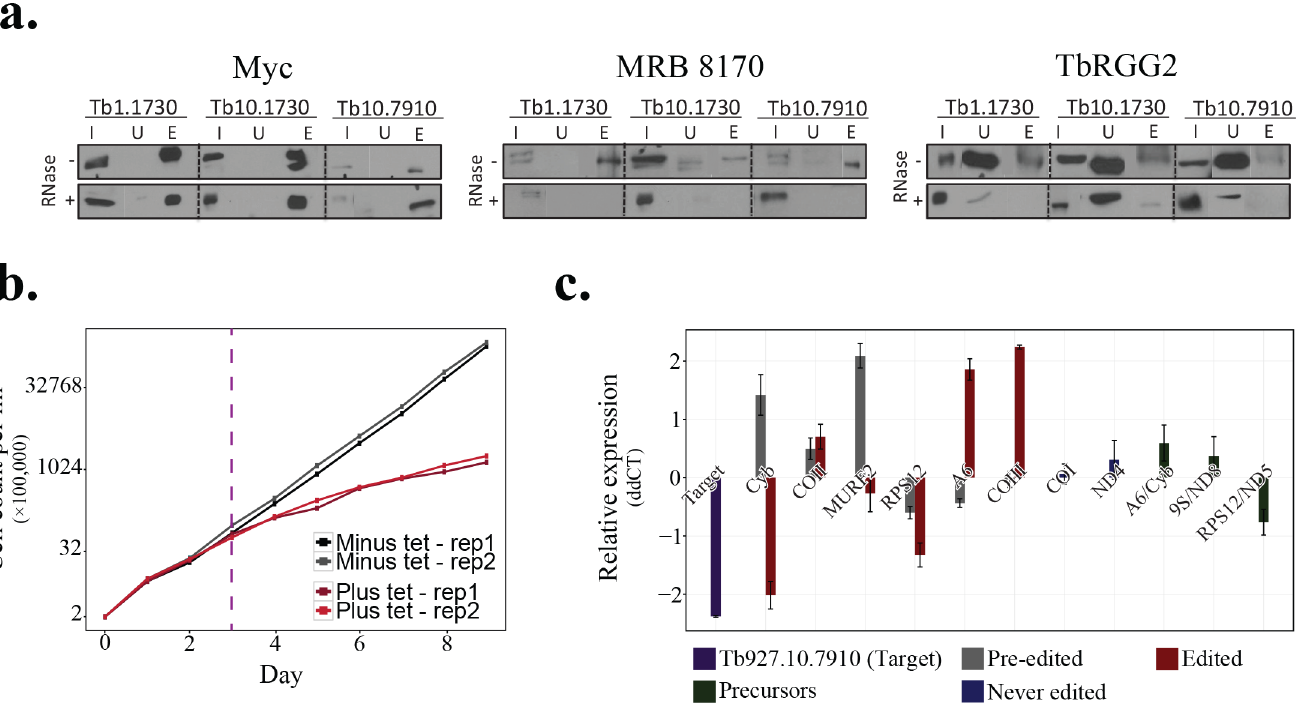
Fig 8. Experimental validation of the candidate proteins. a) Tb927.1.1730 (Tb1.1730), Tb927.10.1730 (Tb10.1730) and Tb927.10.7910 (Tb10.7910) proteins possess interactions with TbRGG2 sub complex.Immunoprecipitation of cmyc-Tb927.1.1730, cmyc-Tb927.10.1730, and cmyc-Tb927.10.7910 from mitochondrial extracts either RNase inhibited (-RNase) or RNase treated (+RNase). Proteins from input (I), unbound (U), and eluate (E) were electrophoresed on 10% SDS-polyacrylamide gel and the blot was probed with specific antibodies against myc (to detect cmyc tag), MRB8170 and TbRGG2. b) Growth curve for Tb927.10.7910 RNAi-knock down experiment. The dashed purple line indicates the selected day (day-3) for collecting RNA sample to examine the knock down effect on mitochondrial transcripts. c) The RNA-editing machinery works on pre-edited mRNA substrates to make edited mRNA; therefore, interfering with this machinery is expected to lead to accumulation of pre-edited and down-regulation of edited mRNAs. We observed this phenotype for the Cyb transcript in knock-down experiment of Tb927.10.7910. The fact that some other edited and pre-edited mtRNAs are also affected can be suggesting that the protein plays multiple functions in the mitochondria gene regulation network of T . brucei . The knock down experiment was performed with two independent biological replicates and three technical replicates (six replicates in